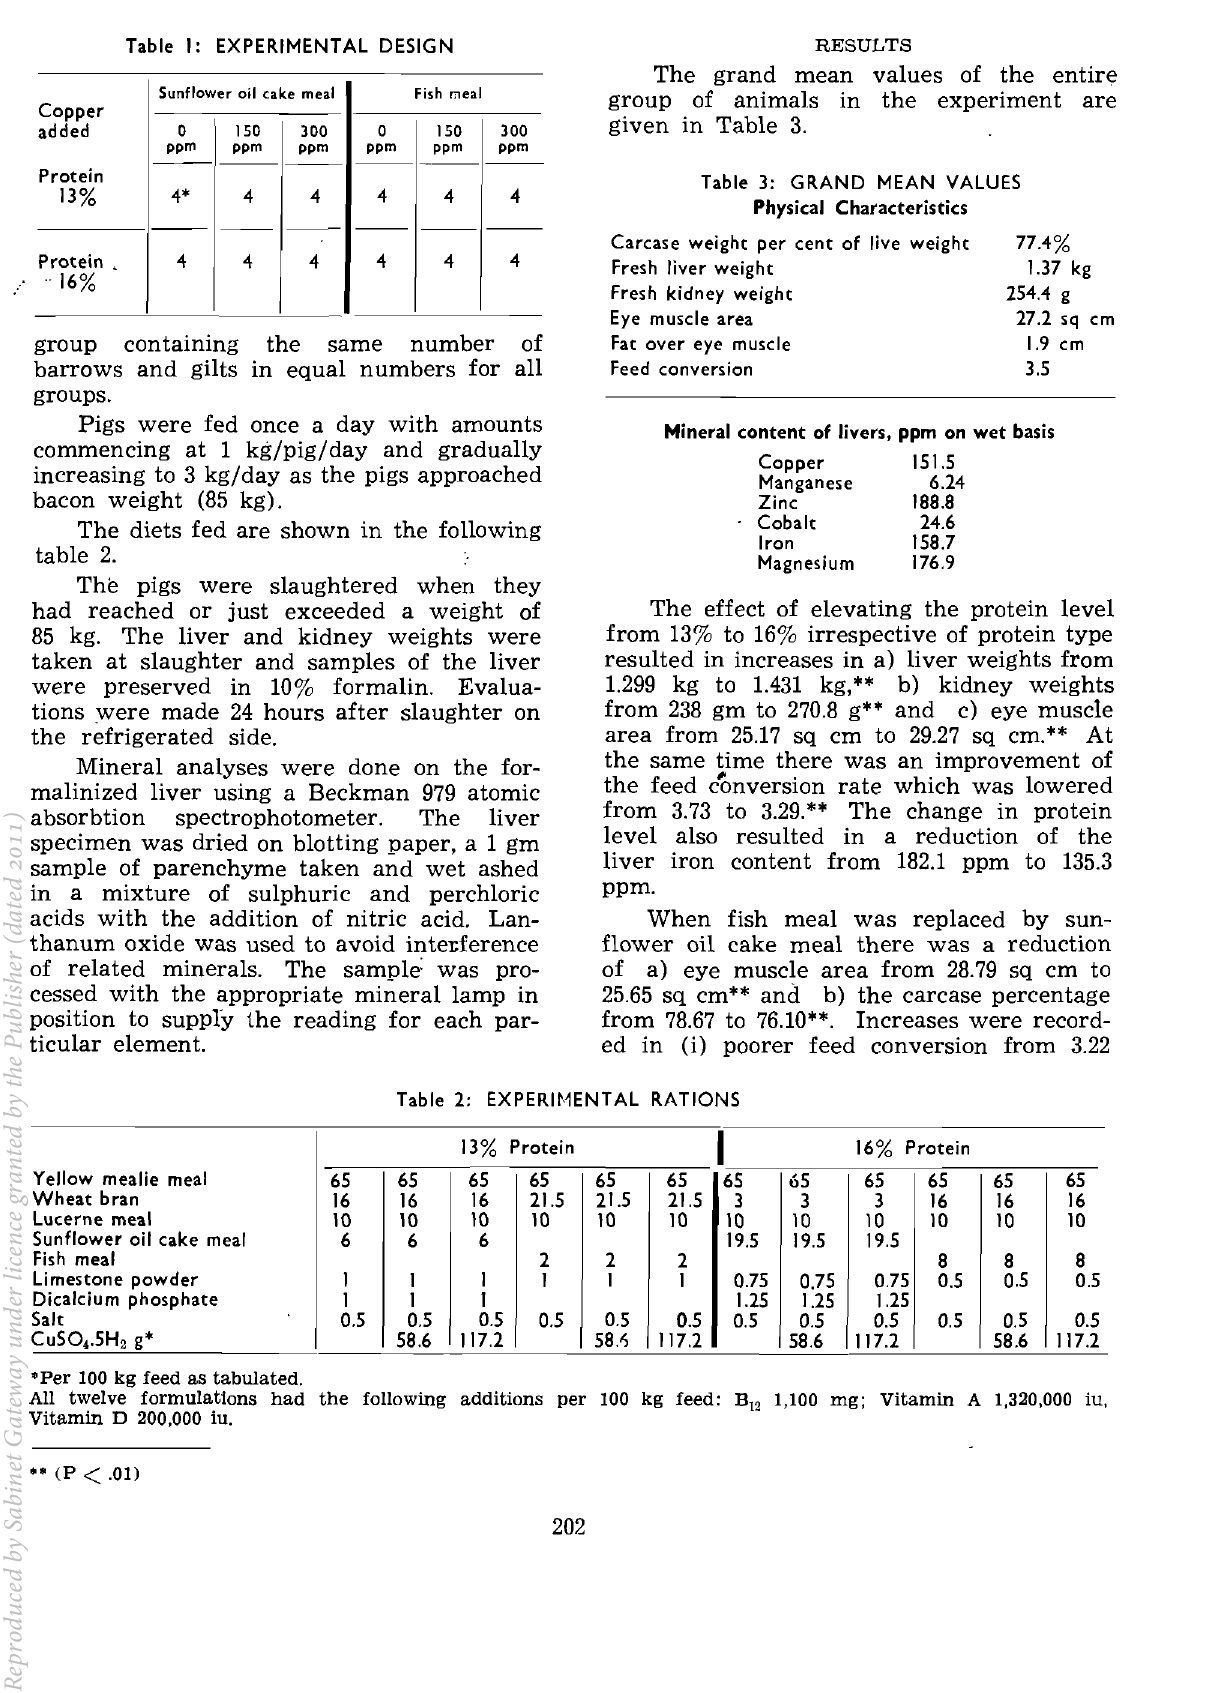
Table 3: GRAND MEAN VALUES Physical Characteristics